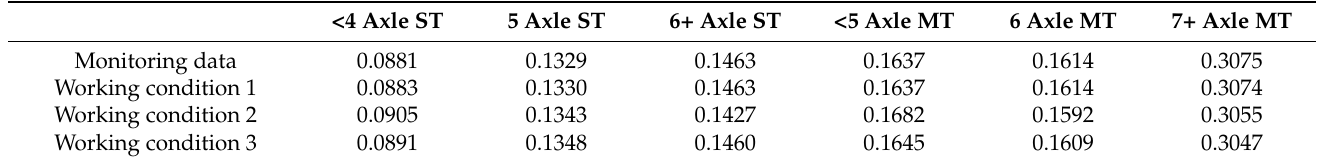
Table 6. The total weight share of each model in the traffic flow.